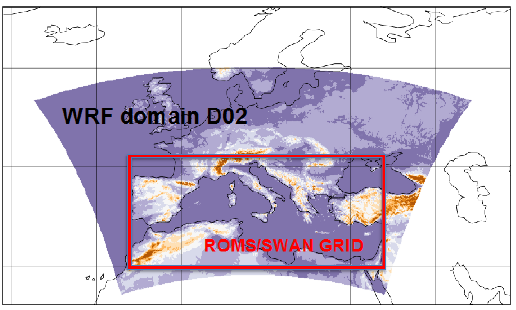
Figure 6. The nested WRF domain and, delimited by the red line, the computational domain used for ROMS-SWAN which included the whole Mediterranean Sea.